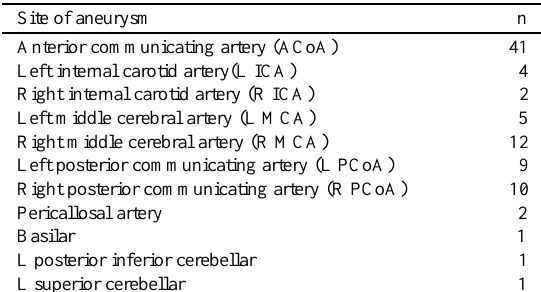
Table 1 Distribution of aneurysm site – all patients Site of